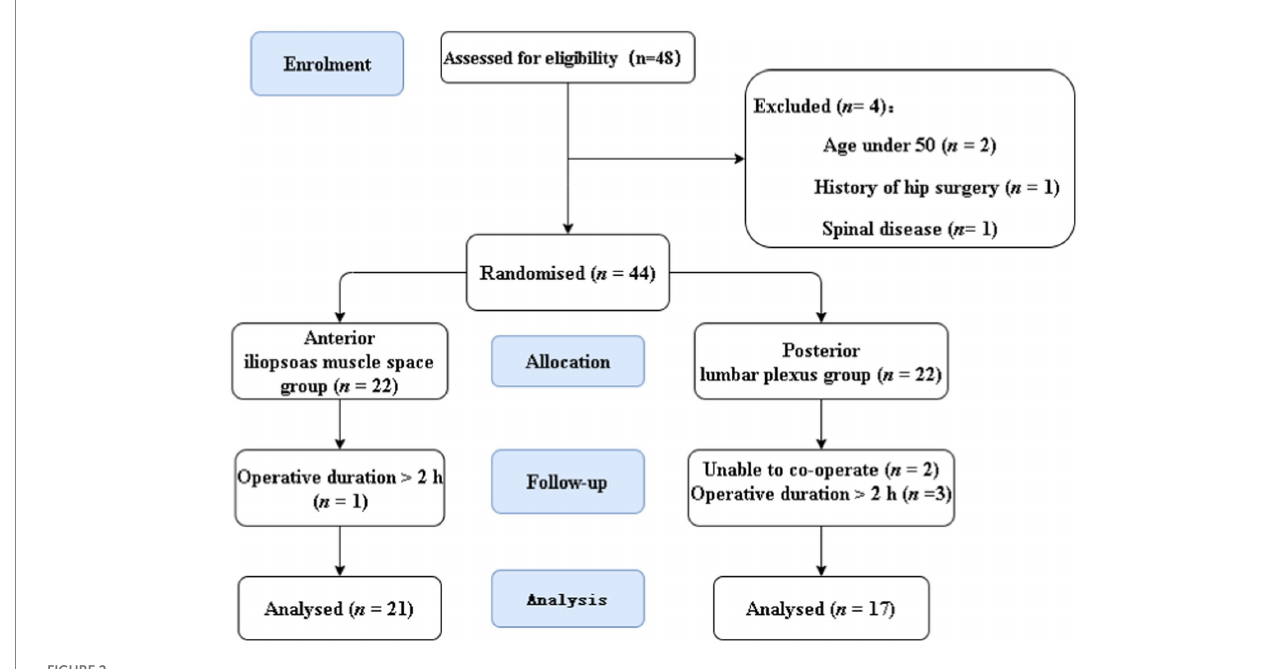
FIGURE 2 CONSORT flow diagram.